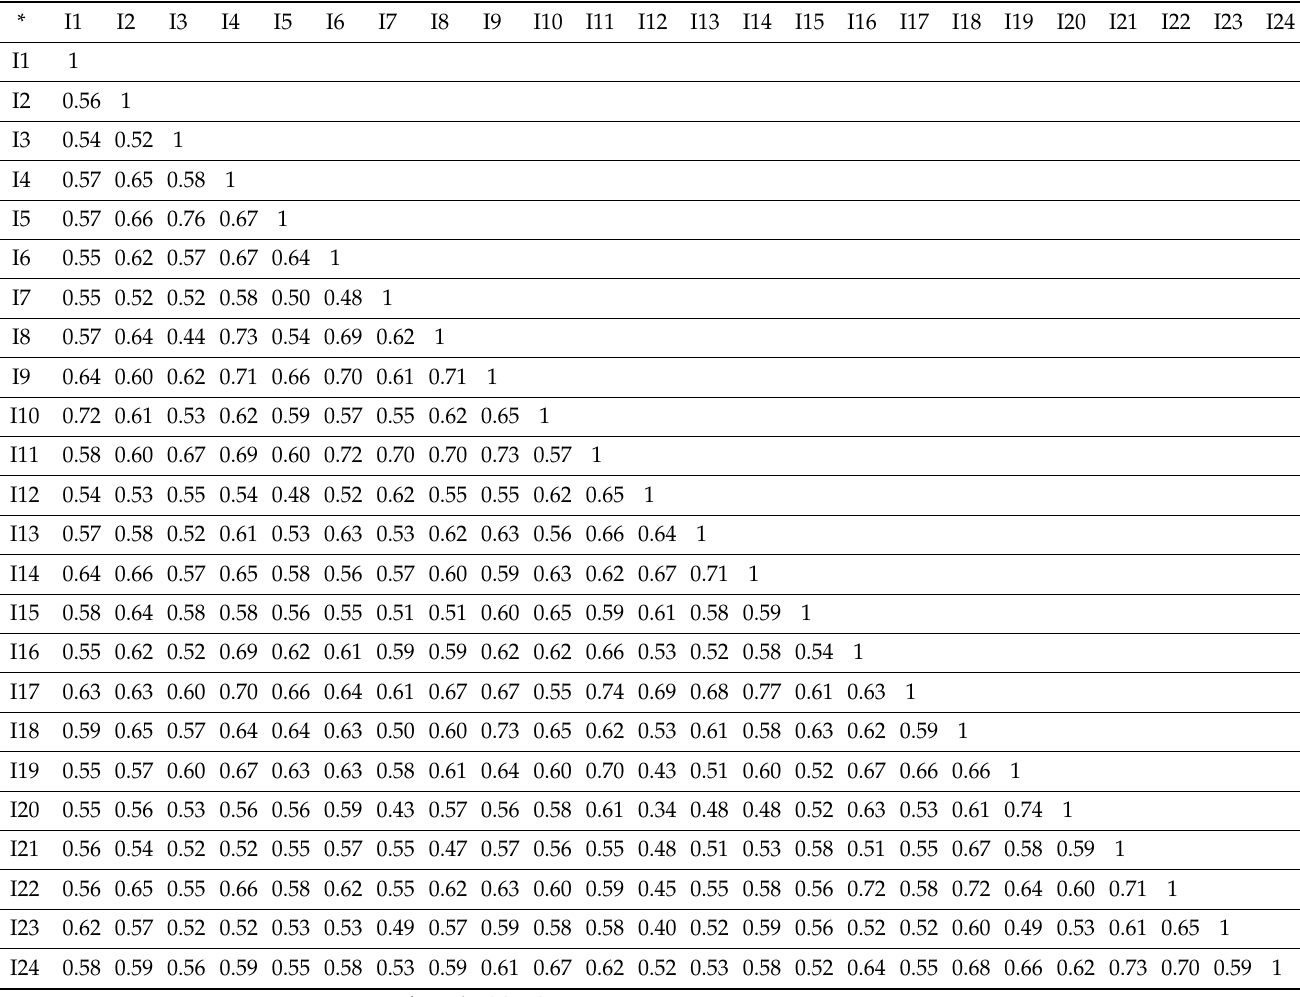
Table 2. Tetrachoric correlation in the older sample for the SCD-Q ( n =